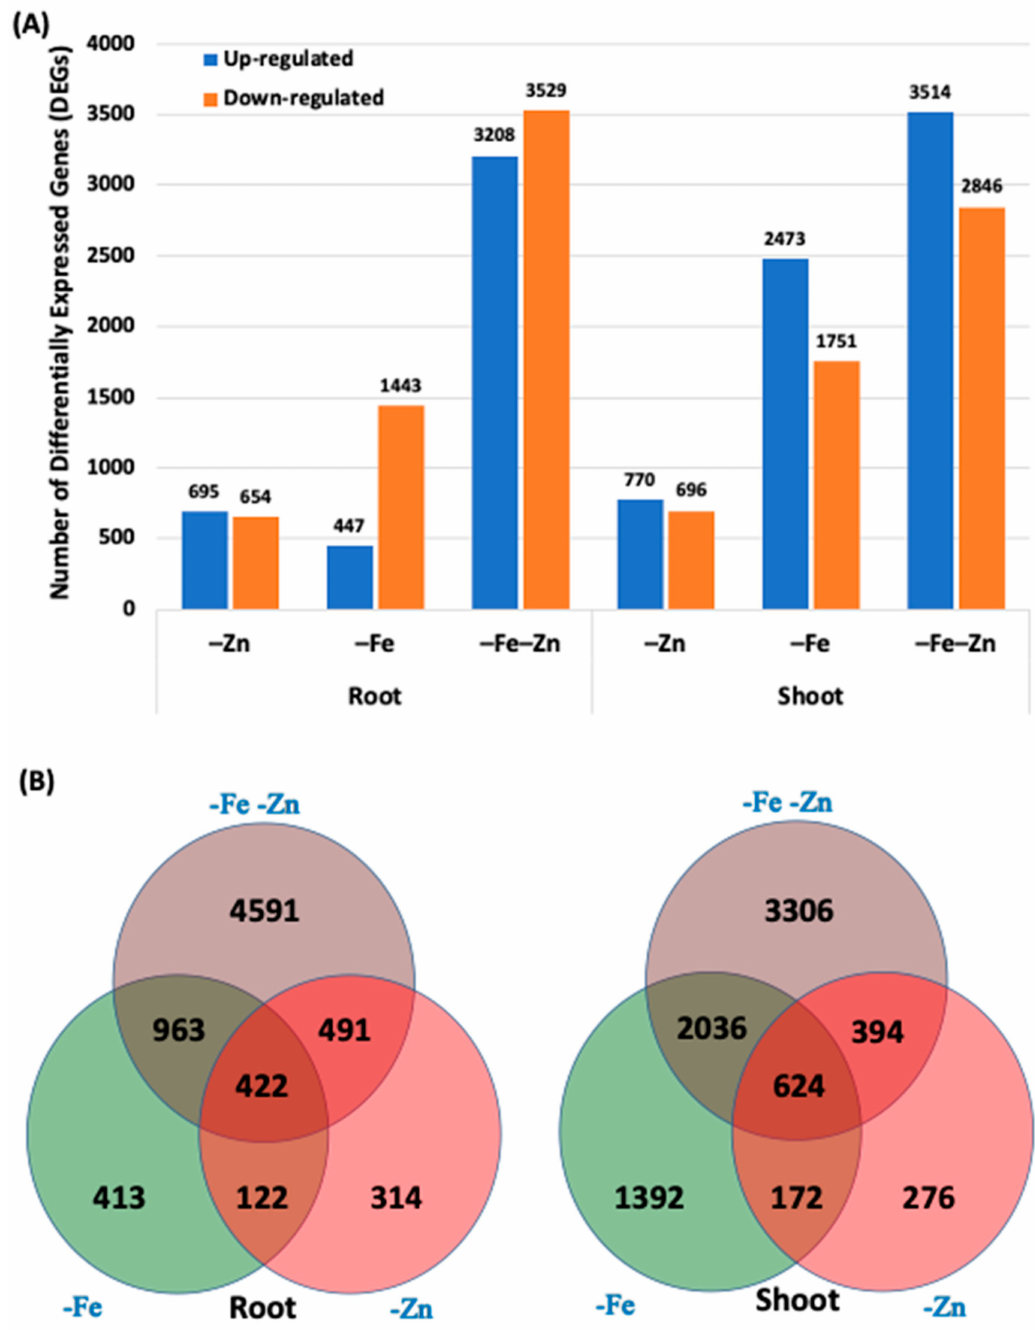
Figure 3. The overview of the spatial transcriptome responses to Fe and Zn stresses in the maize inbred line of SKV616 seedlings. The genes showing > 2-fold expression under stress treatments and p < 0.05 are considered as di ff erentially expressed genes (DEGs) in stress treatments as compared to the control: ( A ) total number of upregulated and downregulated genes in response to –Zn, –Fe and –Fe–Zn stresses in the root and shoot; and ( B ) the Venn diagram depicting the stress-specific and common DEGs in response to –Zn, –Fe and –Zn–Fe stresses in the root and shoot